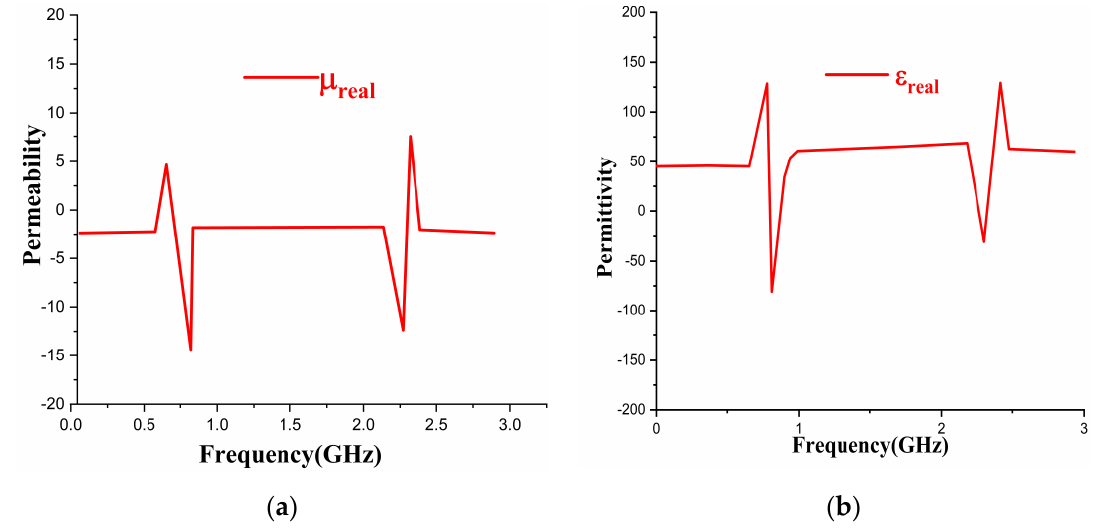
Figure 9. Results of Unit Cell Structure, ( a ) Permeability, ( b ) Permittivity.